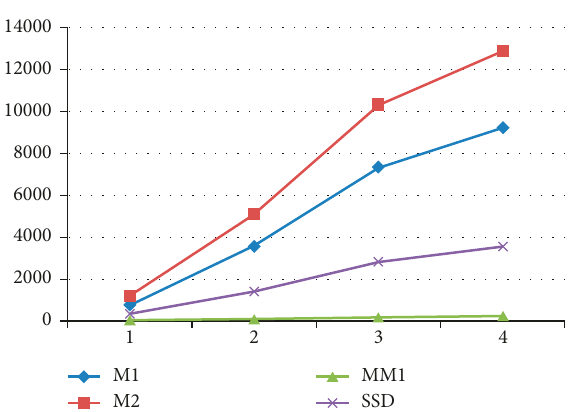
Figure 5: Comparison between different Zagreb indices of (TM- TCNB) 2 .